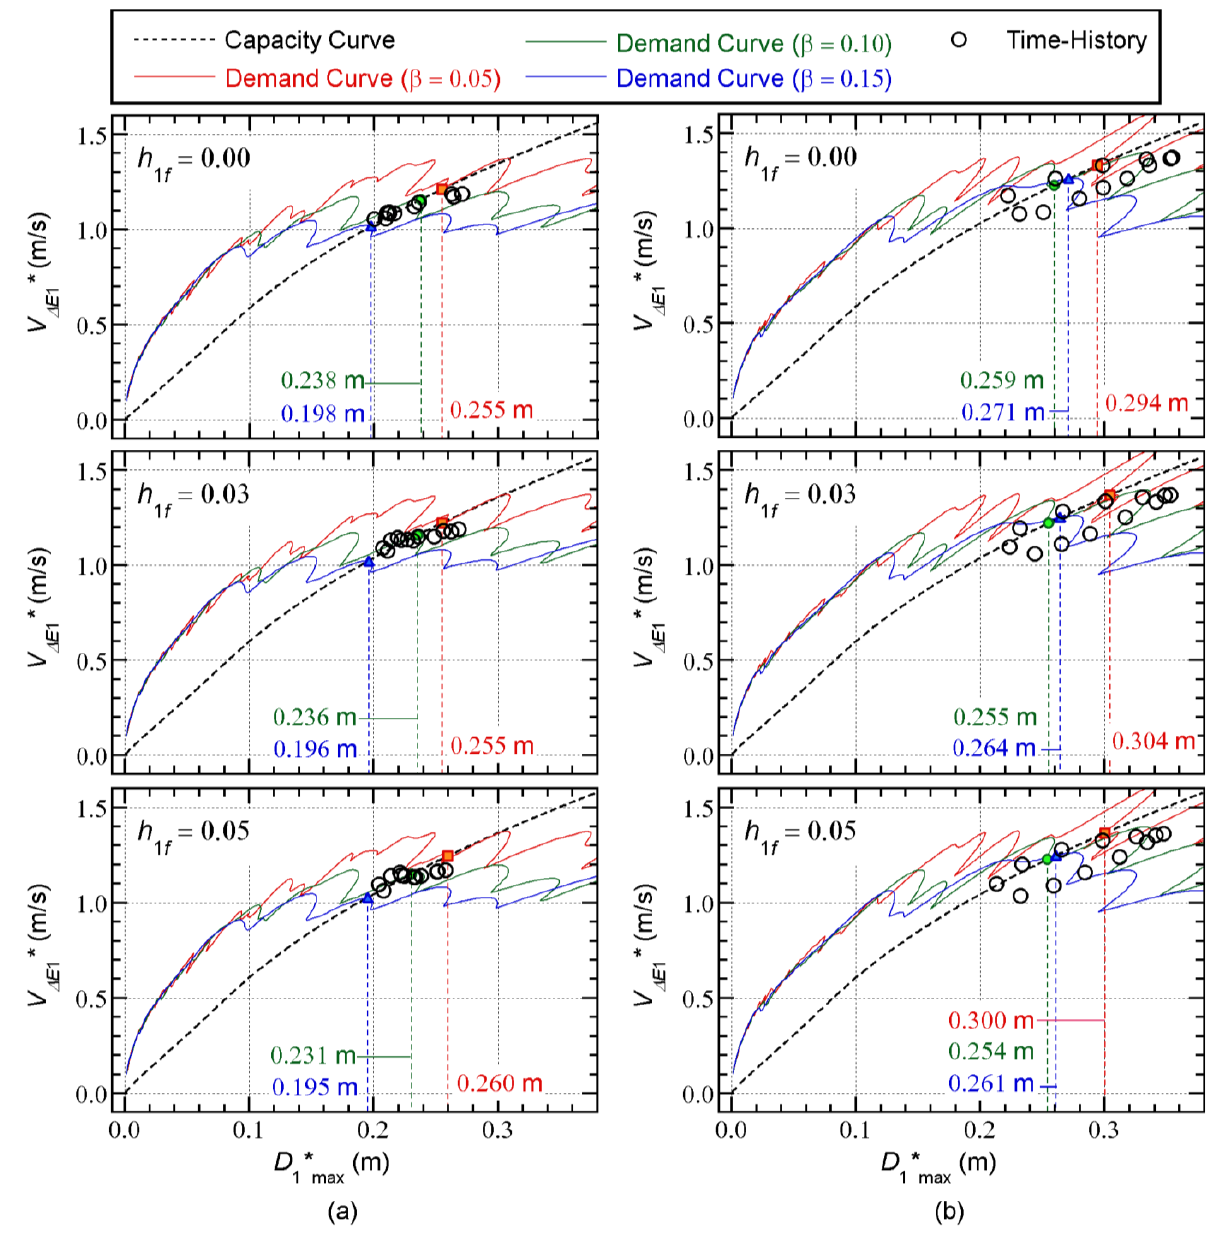
Figure 20. Comparisons between the capacity curve and the V ∆ E 1 ∗ - D 1 ∗ max relationship obtained from the time-history analysis results (8-story model): ( a ) Art-L series; ( b ) Art-S series.